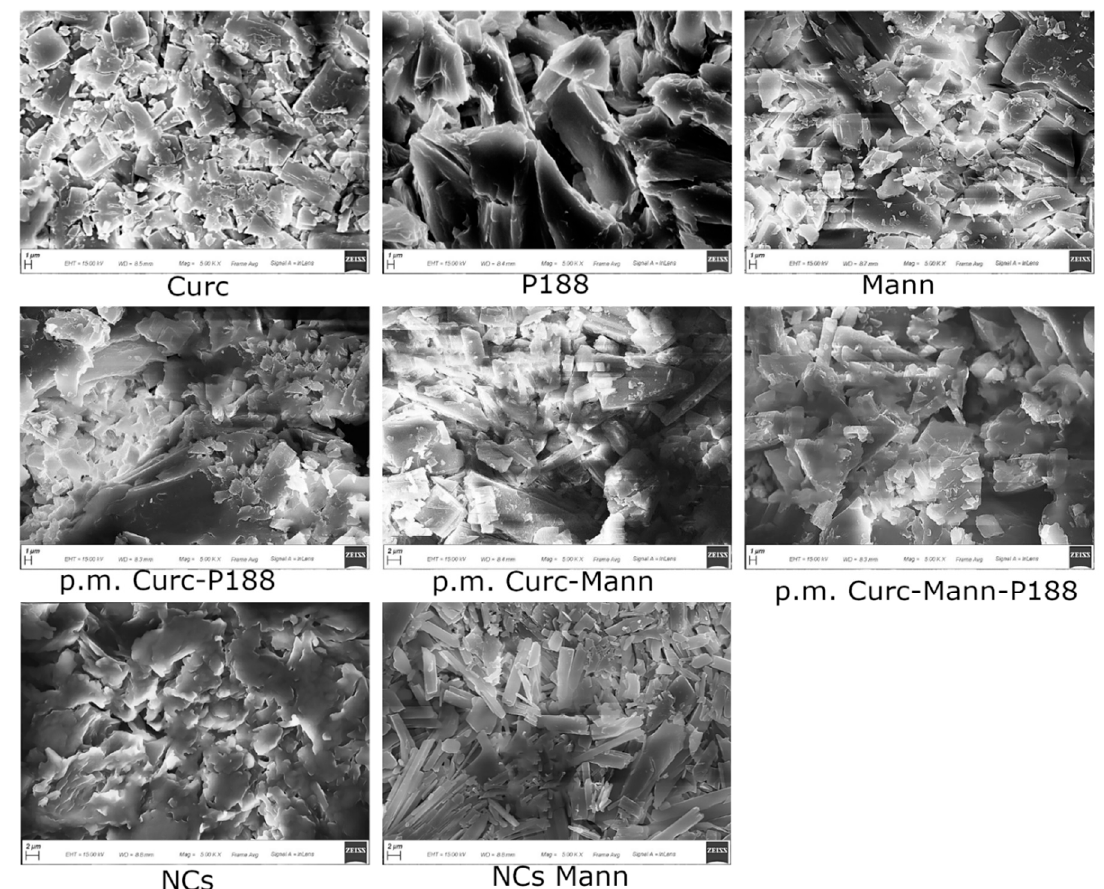
Figure 5. Scanning electron microscopy of different samples (X5000). Details of named samples: curcumin (Curc); mannitol (Mann); poloxamer 188 (P188); physical mix curcumin and poloxamer 188 (p.m. Curc-P188); physical mix curcumin, mannitol and poloxamer 188 (p.m. Curc-Mann-P188); physical mix curcumin and mannitol (p.m. Curc-Mann); nanocrystals (NCs); nanocrystals with mannitol (NCs Mann).